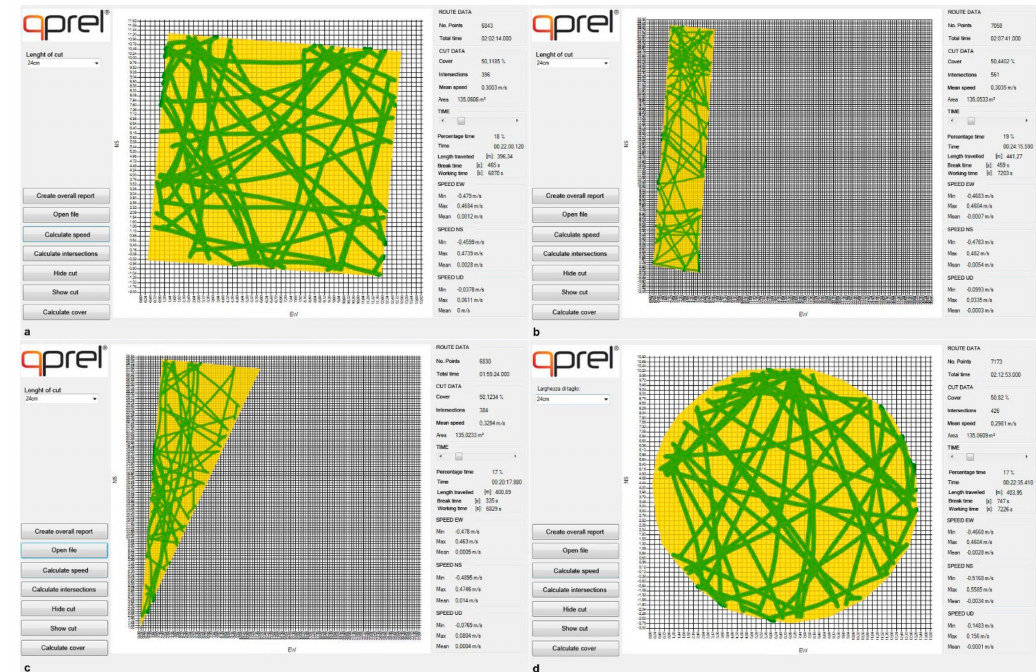
Figure 5. Screenshots of the software “Robot mower tracking data calculator” showing the di ff erent turfgrass area shapes with an area of 135 m 2 selected (yellow area shapes): ( a ) Square, ( b ) rectangle, ( c ) triangle, and ( d ) circle. In these screenshots the percentage of cut area was 50% (green